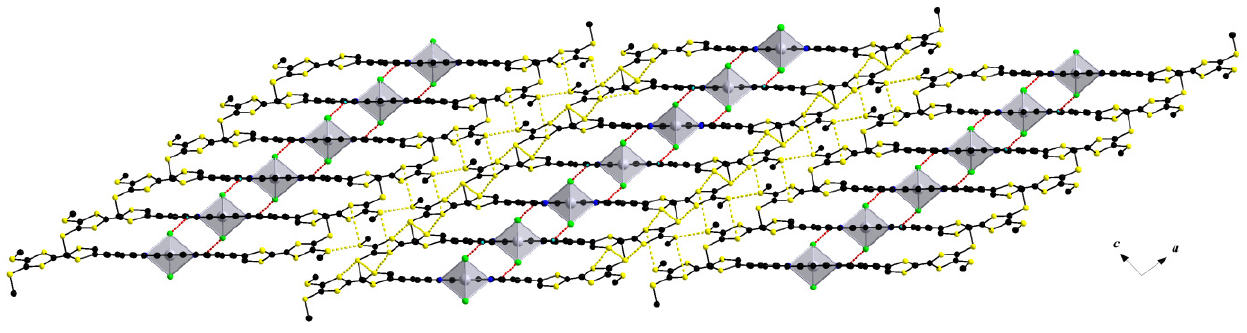
Figure 5. The crystal packing in 4 showing the non-conventional hydrogen bonds (red dashed lines) and S···S (yellow dashed lines) interactions.